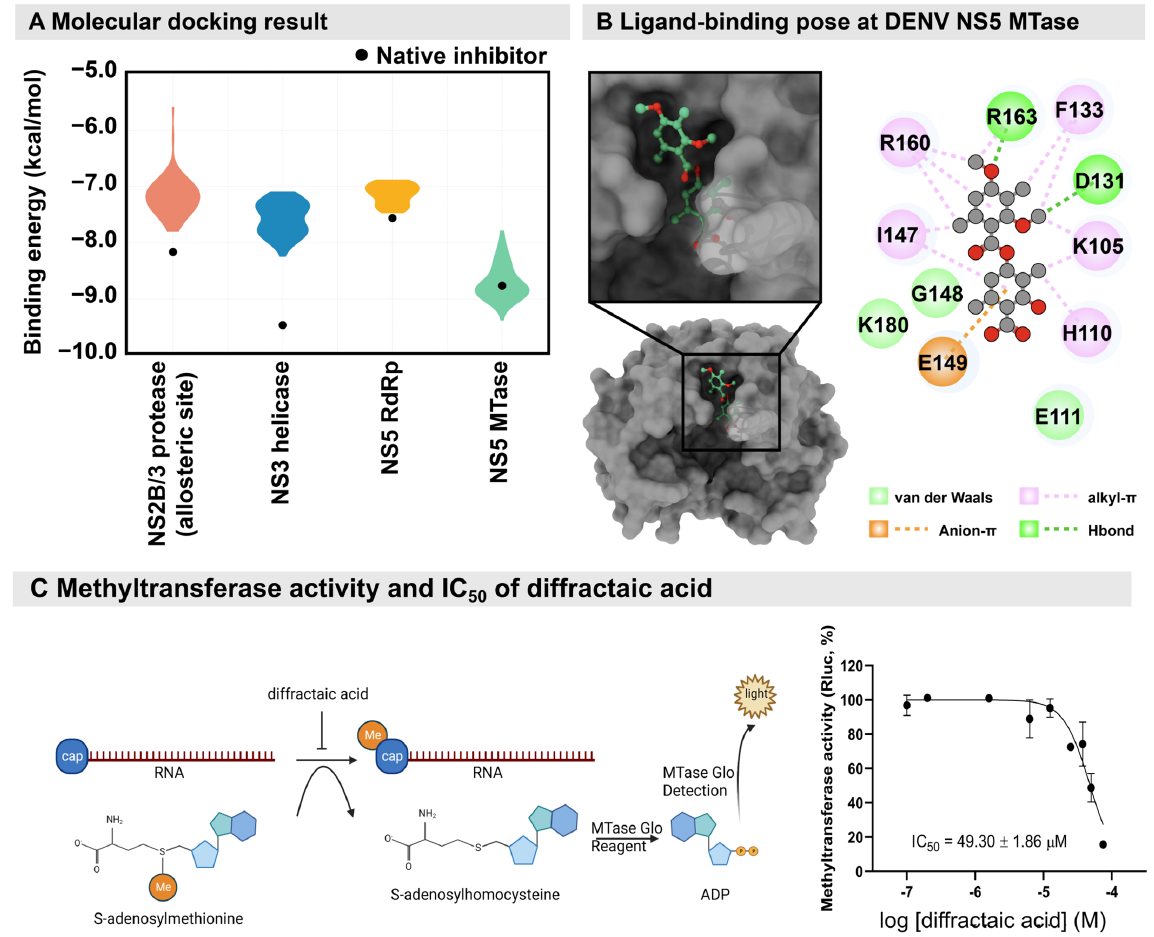
Figure 4. ( A ) Molecular docking of diffractaic acid toward DENV viral proteins; NS2/3 protease at allosteric site (salmon), NS3 helicase (blue), NS5 RdRp (yellow), and NS5 MTase (green), compared to native inhibitors of each target (black dot). ( B ) The preferential binding conformation of diffractaic acid (green) in complex with NS5 MTase (gray) presented as the ligand conformation and 2D interaction. ( C ) Schematics of the methyltransferase assay and an inhibitory concentration (IC 50 ) of diffractaic acid.